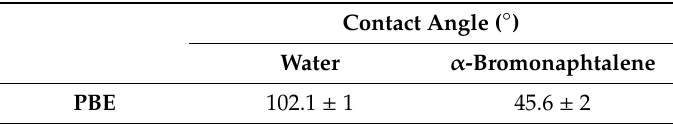
Table 6. Contact angle ( ◦ ) of PBE with water and α -Bromonaphtalene.